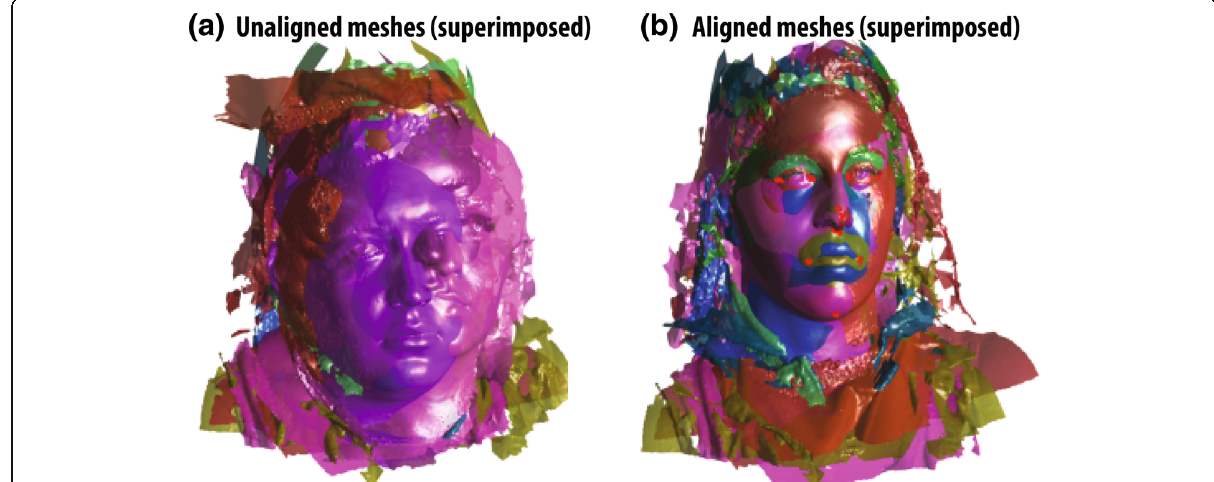
Fig. 2 Applying generalized Procrustes analysis (GPA) transforms to meshes. a Before meshes are aligned. b After aligning the meshes by translation, rotation, and scaling using nine facial landmarks